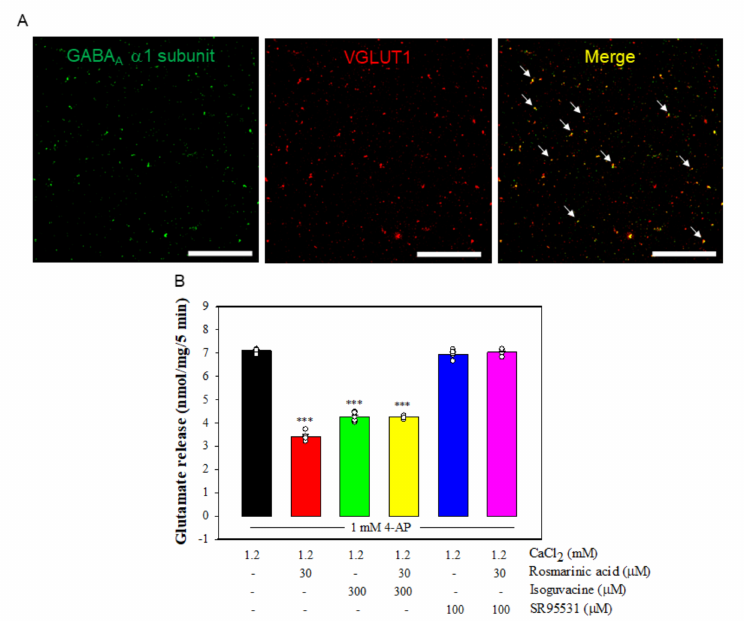
Figure 5. ( A ) GABA A receptor α 1 subunits are present in VGLUT1-positive synaptosomal particles isolated from the rat cerebral cortex. Confocal microscopy unveiled a significant colocalization of VGLUT1 (red) and GABA A receptor α 1 subunit (green) immunopositivities (yellow, merge, arrowhead). Scale bar: 100 µ m. ( B ) Effect of rosmarinic acid on 4-AP-evoked glutamate release in the presence of isoguvacine and SR95531, GABA A receptor agonist and antagonist, respectively. Isoguvacine or SR95531 was added 10 min before the addition of 4-AP. Data are mean ± SEM ( n = 5 per group). *** p < 0.001 compared with the control group.